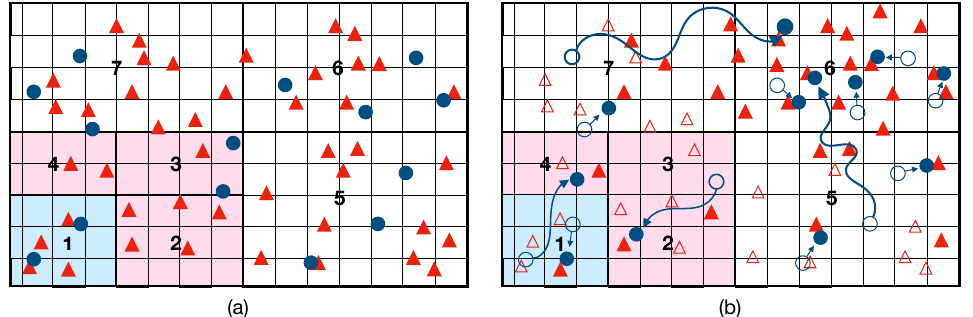
Figure 3. Soft locally interactive structure in the global state space. ( a ) The normalized distribution of Figure 5: Locality of interaction in multi-agent systems with time-varying spatially distributed interest- points. (a) Recursive state space decomposition. The planning problem for subregion 1 is agents and interest-points are approximately equal at the resolution of regions conditionally independent of subregions 2, 3 and 4 because these regions have approximately the so the optimal agent activity in regions same density of interest-points and agents. Similarly, the planning problem for their union is points drift into region 6, destabilizing the equilibrium between the normalized distributions. Options conditionally independent of regions 5-7. (b) Temporal/hierarchical task space decomposition. Primitive actions move agents within each subregion. Macro-actions move agents between or “macro-actions” move agents across regions to restore this equilibrium and “localize” the opti- subregions. Higher level macro-actions move agents between larger “macro” regions. mal